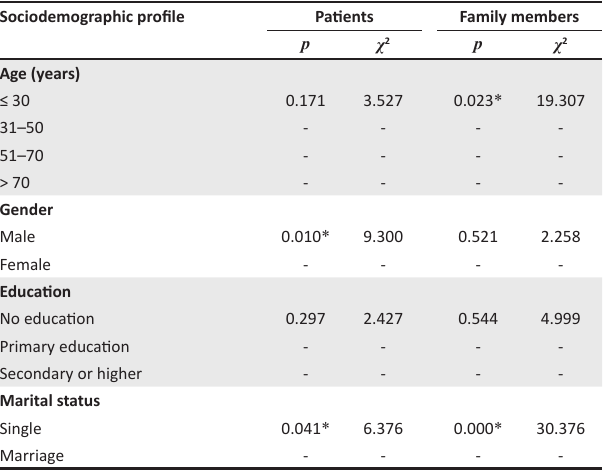
BMI, body mass index. FIGURE 1: Body mass index of TABLE 2: Body mass index by sociodemographic profile of respondents.